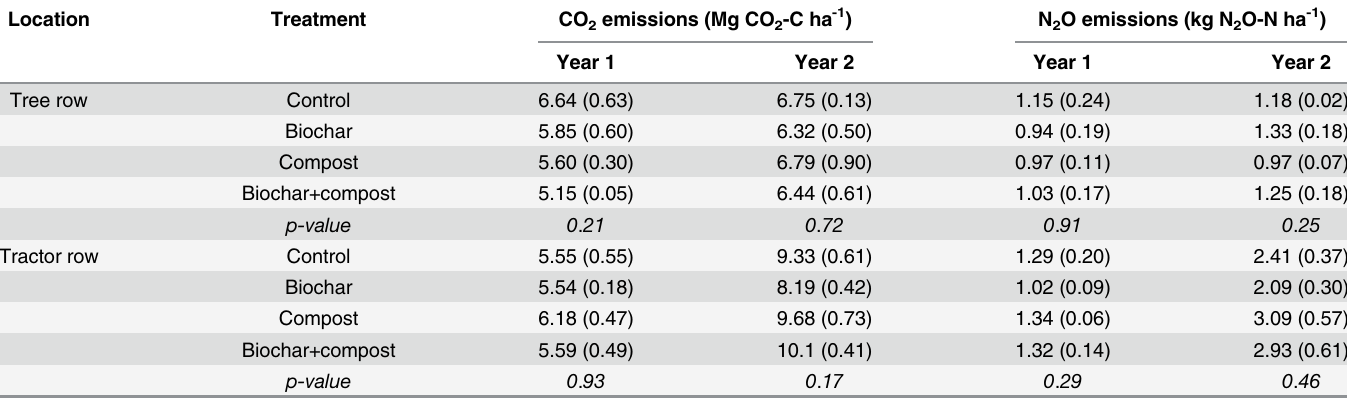
Table 2. Cumulative CO 2 – C and N 2 O-N emissions by sampling year from both tree and tractor rows of a walnut orchard in Winters, CA, USA. Shown in parentheses is ± one standard error (n = 3). None of the treatments significantly altered the cumulative CO 2 – C and N 2 O-N emissions at p < 0.05.